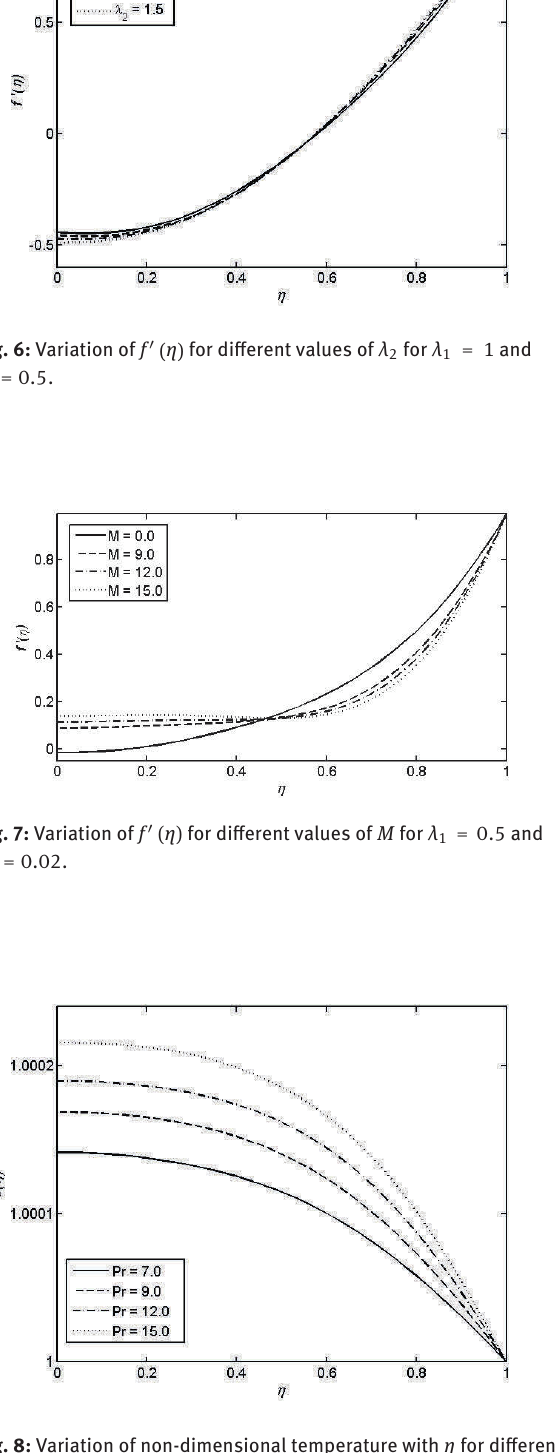
Fig. 8: Variation of non-dimensional temperature with η for different values of Prandtl number Pr for λ 1 = 0.5, M = 0.5 and λ 2 =